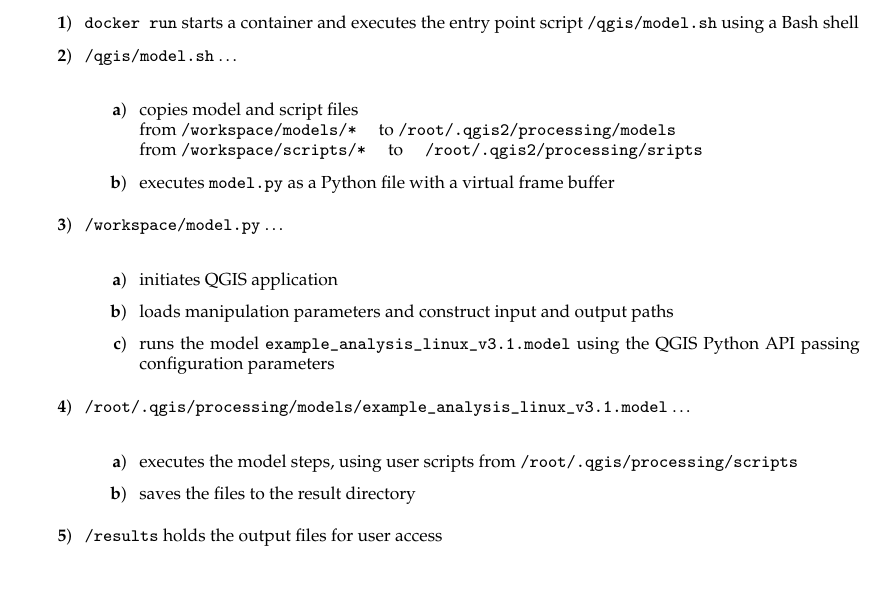
Figure 5. Control flow during an execution of the Docker container in a list of numbered steps. Starting from the command docker run , the control flow goes through two script files, one in Bash and one in Python, each in turn acting on other files and being configured using environment